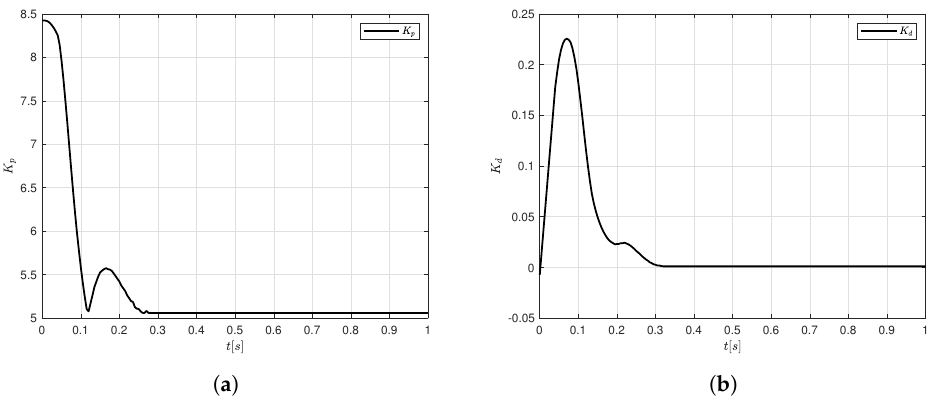
Figure 11. Controller gains response for the step signal ( a ) K p and ( b ) K d .